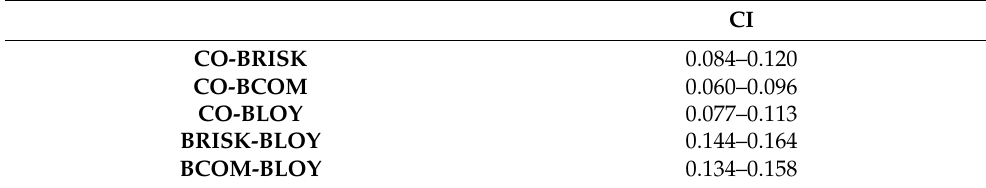
Table 8. Interval Confidence.